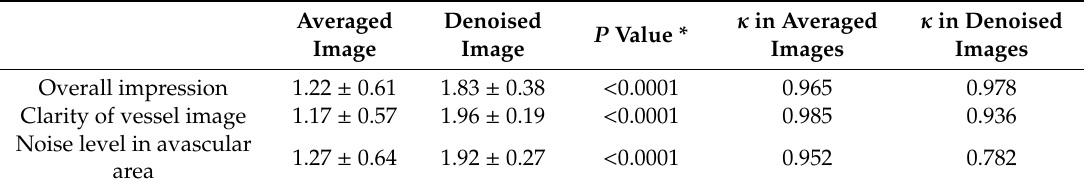
Table 2. Average scores for subjective image quality assessment of optical coherence tomography angiography